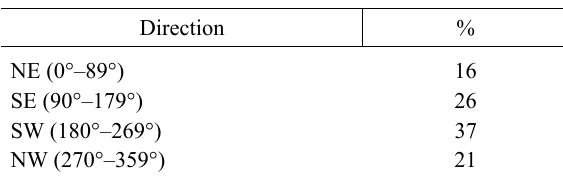
Table 1. Percentage of winds from different directions on the Gulf of Finland in winters of 1971(cid:150)2005 (1 Jan to 1 May) from the NCEP/NCAR reanalysis data